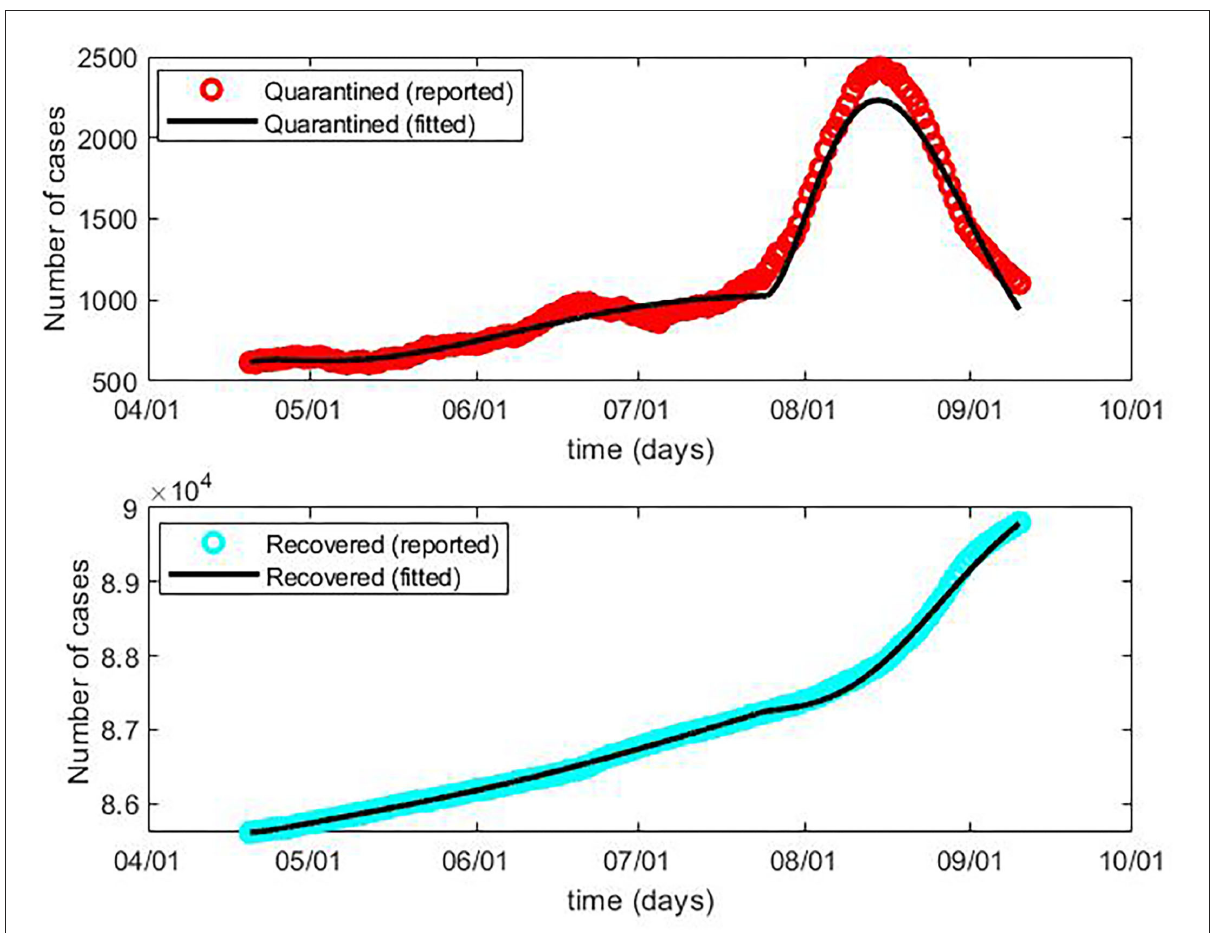
FIGURE1 The reported and fitted current quarantined cases and cumulative recovered cases of COVID-19, China, 20 April to 10 September.